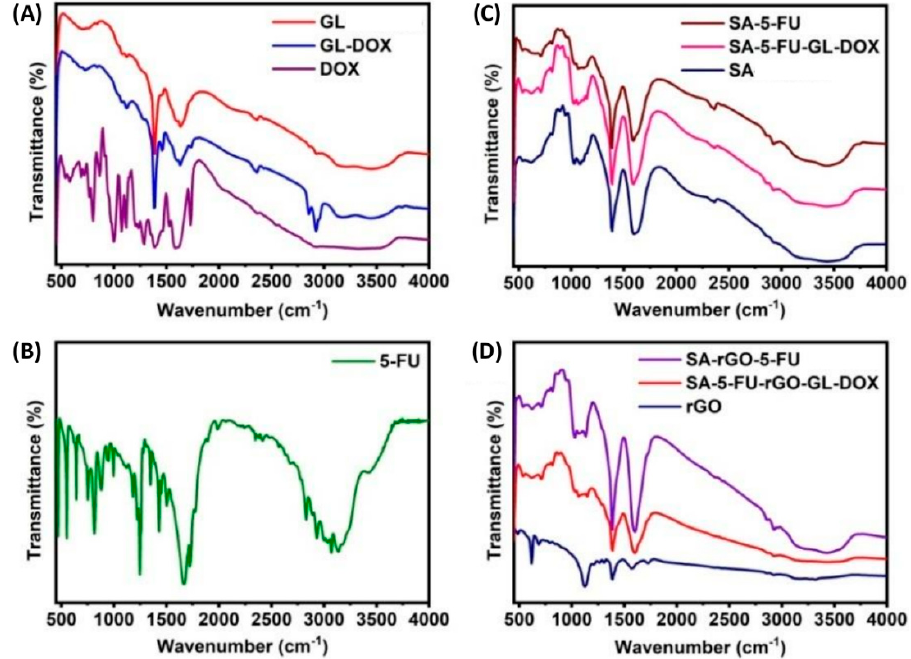
Figure 1. FTIR spectra of different samples: ( A ) DOX, GL-DOX and GL beads; ( B ) 5-FU; ( C ) SA-rGO-5-FU, SA-5-FU and SA beads; ( D ) rGO, SA-rGO-5-FU and SA-5-FU-rGO-GL-DOX.